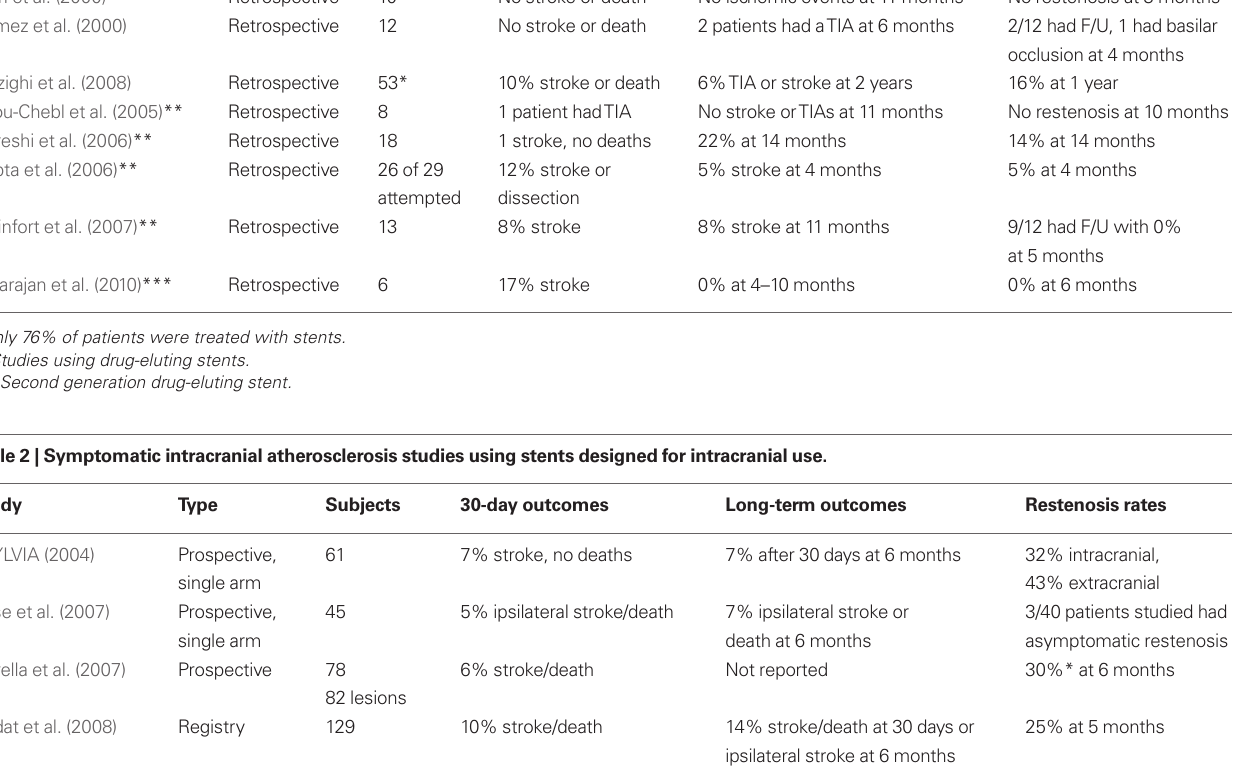
Table 1 | Summary of coronary stent studies used for treatment of intracranial stenosis. Study